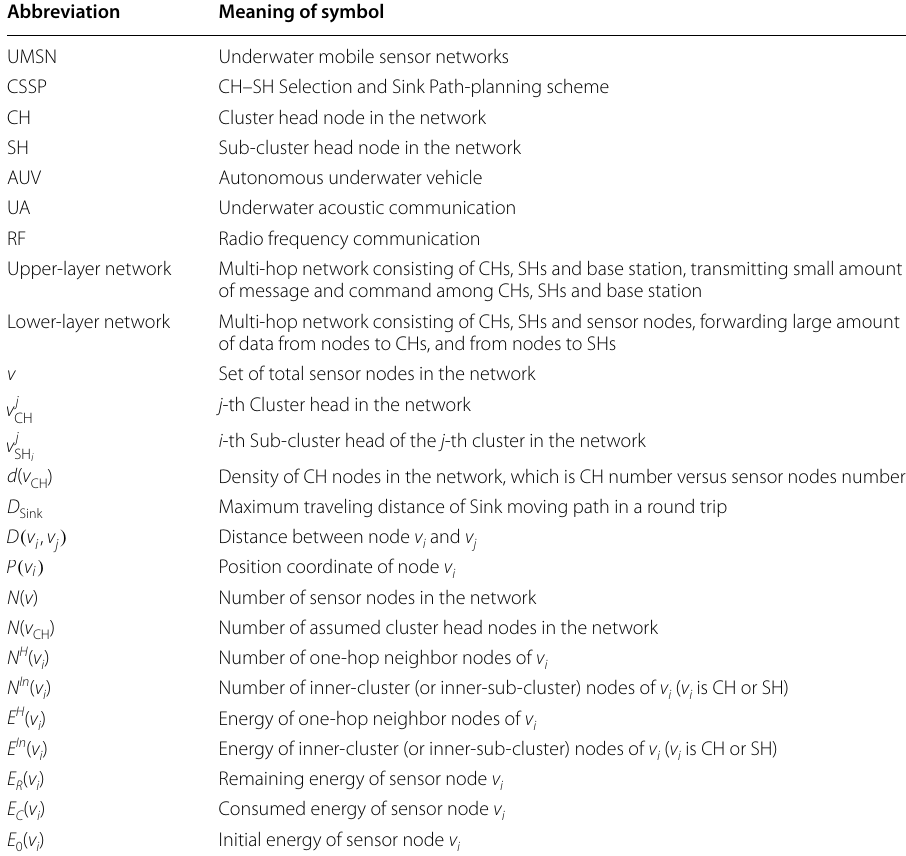
Table 1 The abbreviation of used symbols in network model